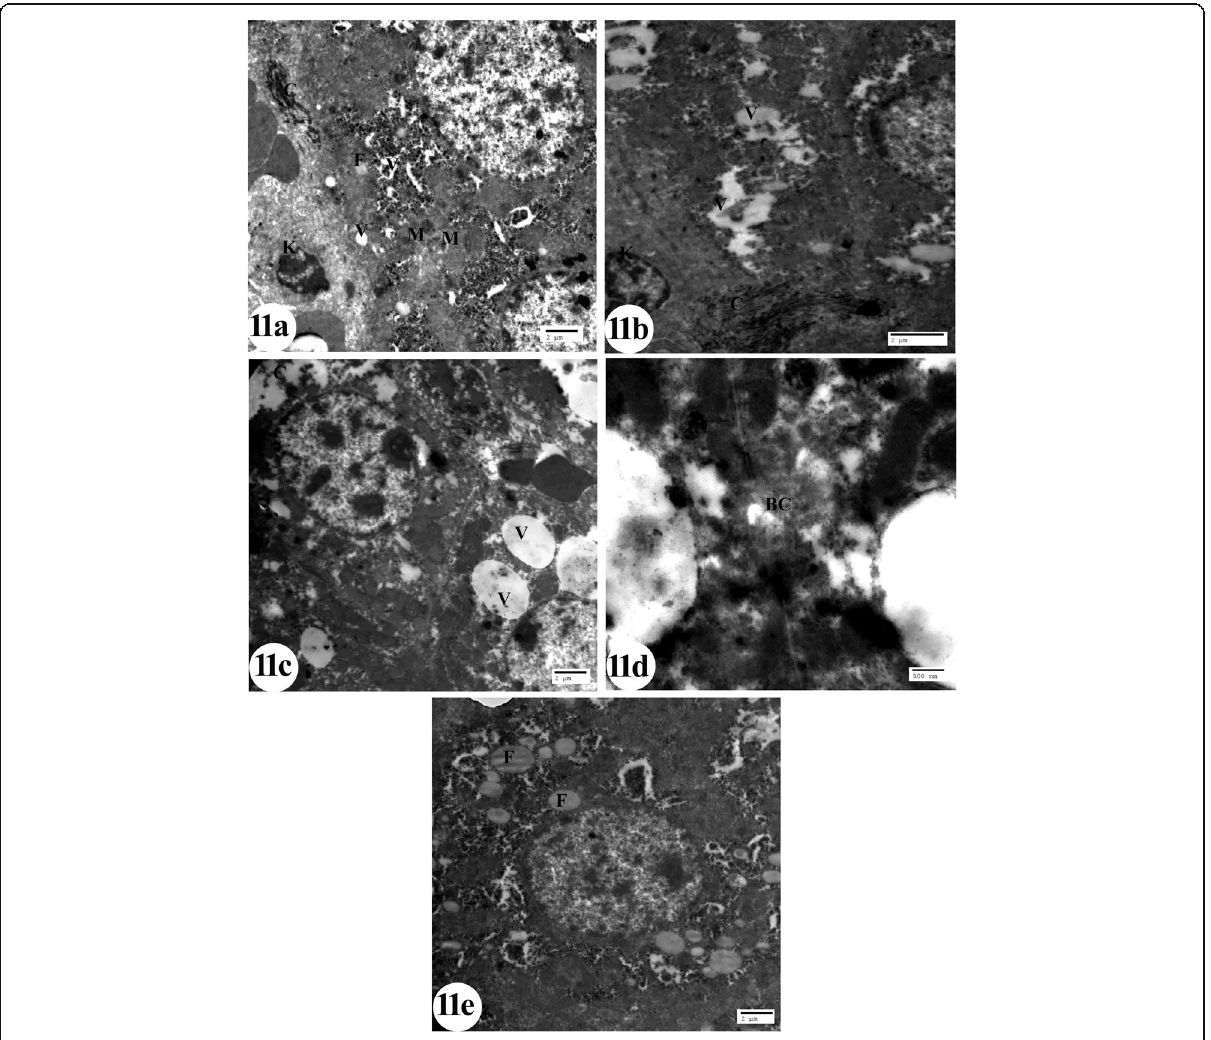
Fig. 11 Electron micrographs of a sections of liver of rats treated with LCT a – c , e showing hepatocytes with cytoplasmic vacuolations (V), vacuolated mitochondria (M), fat droplets (F), collagen fibers (C), and damaged Kuppfer cell (K) (scale bar = 2 μ m). d Bile canaliculi with damaged microvilli (BC) (scale bar = 500